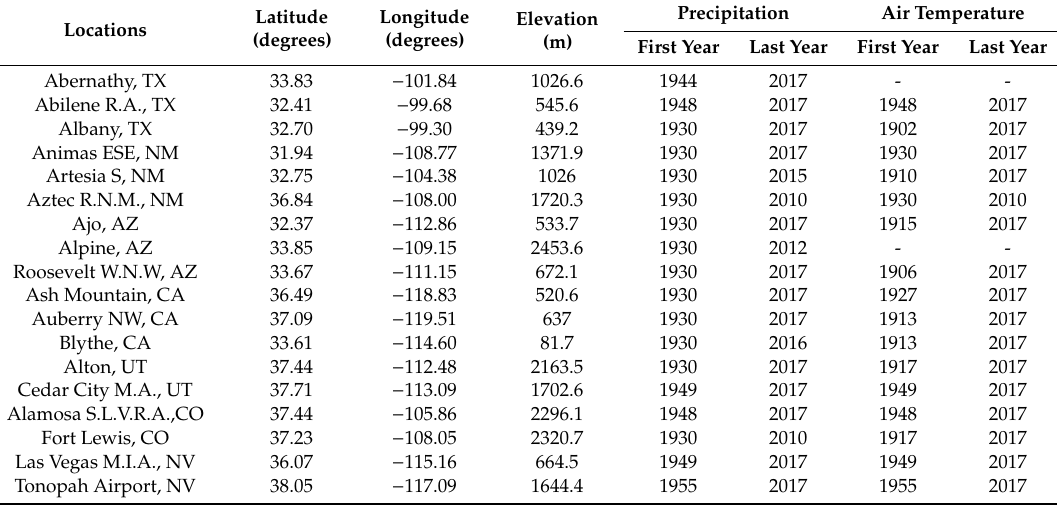
Table 1. Weather station geographic coordinates with the data collection periods for daily precipitation and air